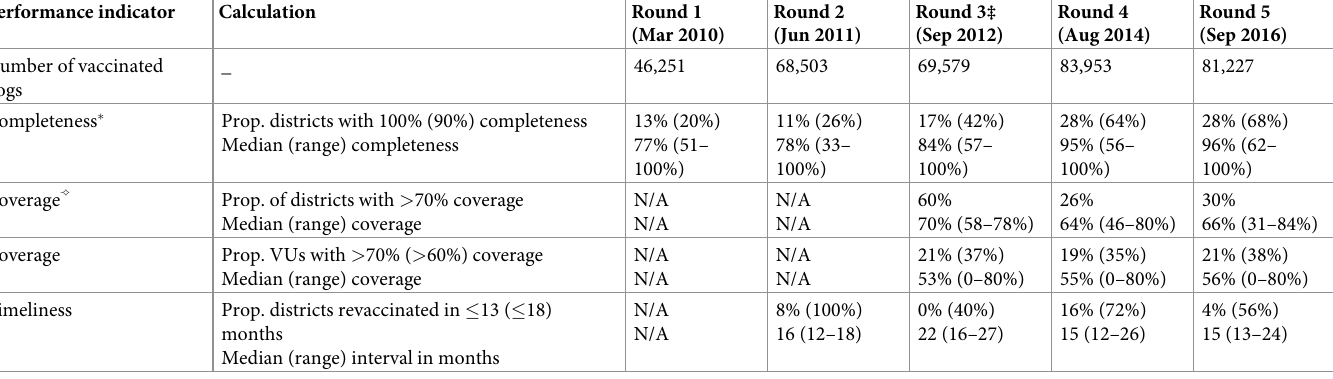
Table 3. Summary of the performance of vaccination campaigns in terms of completeness, coverage and timeliness for the 25 study districts over the five rounds of vaccinations from 2010–2017. Performance